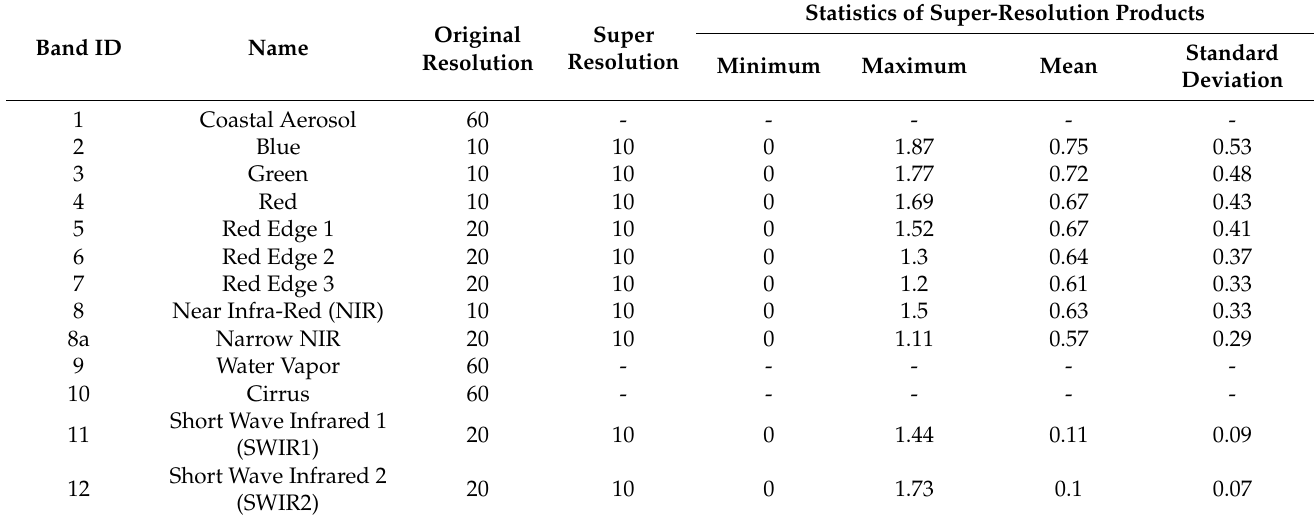
Table 1. Band information and statistics of the multispectral image of the study area in Bome